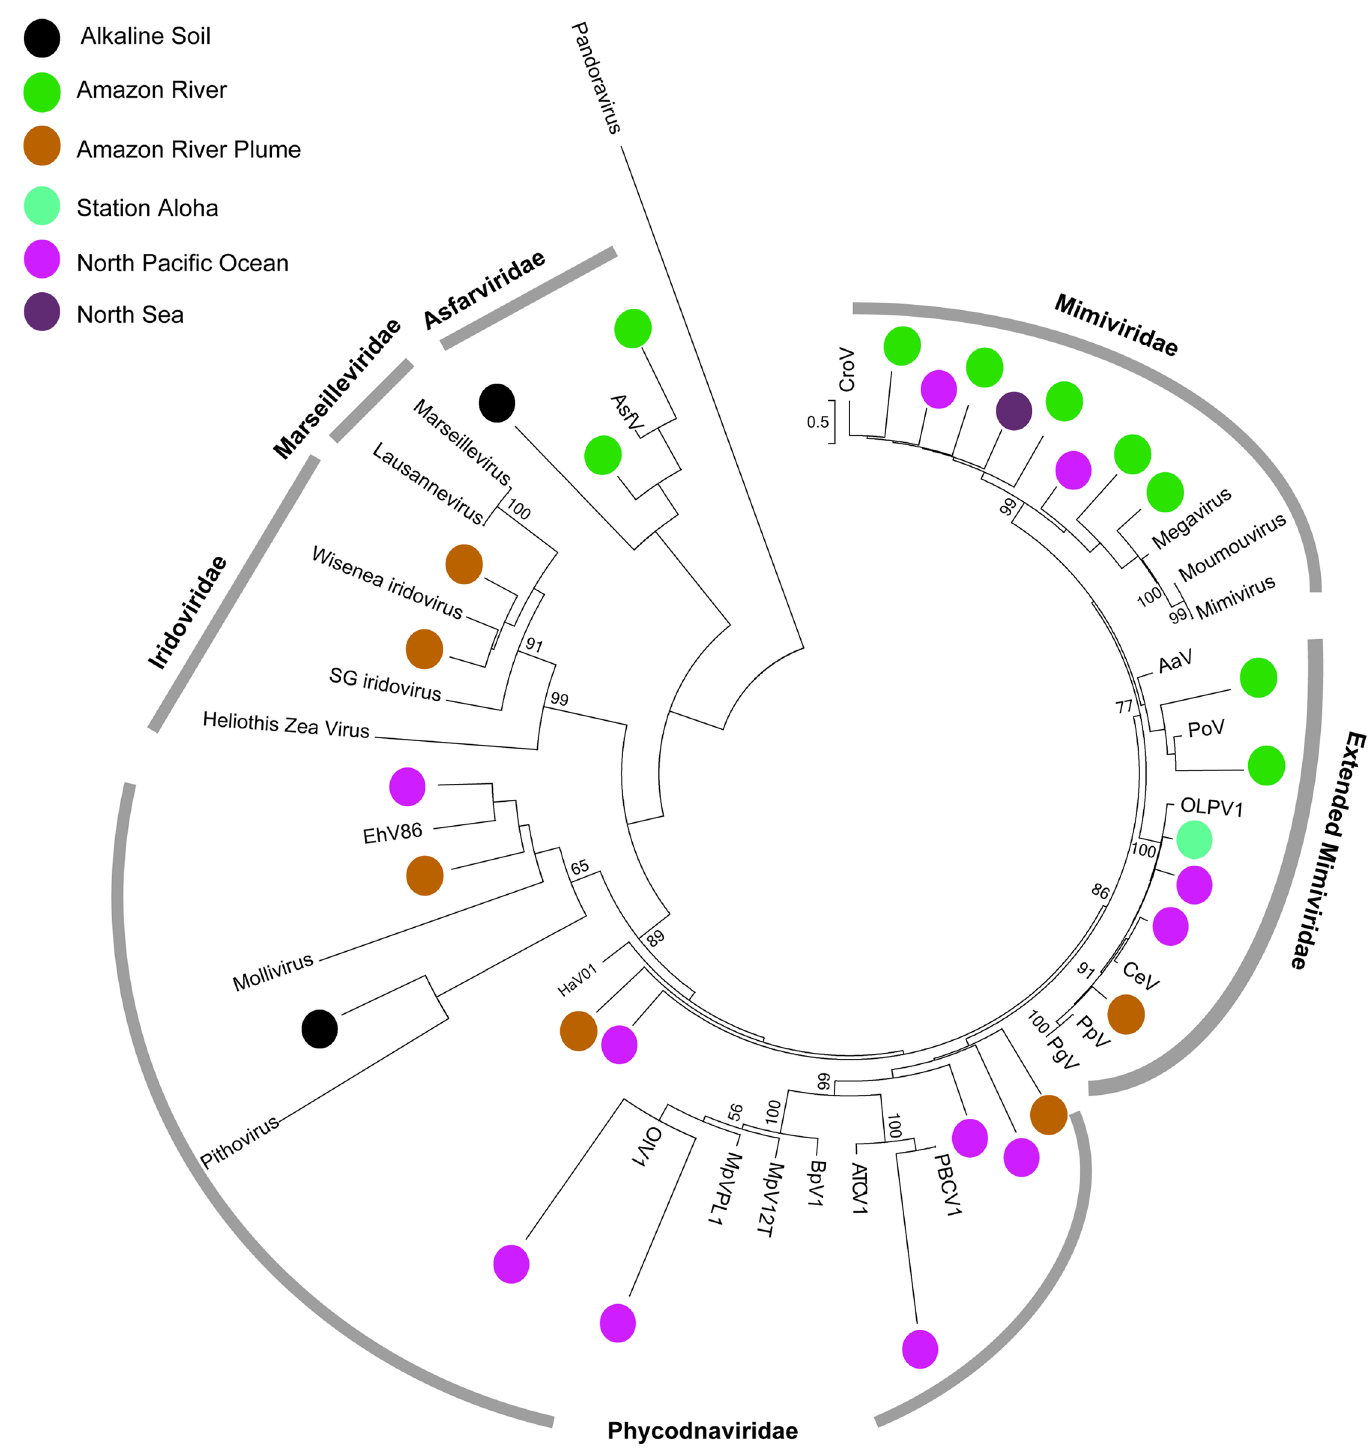
Fig 1. Phylogenetic reconstruction of NCLDV major capsid protein sequences from environmental metatranscriptomes generated from an alkaline soil sample (NCBI ID: SRP043976), the Amazon River and River Delta (SRP037995, SRP039544 [21]), the North Pacific Ocean (SRP052554 [22]), Station ALOHA in the tropical Pacific Ocean (CAM_SMPL_000824 at iMicrobe.us [23]), and the North Sea (ERP004582 [24]). Public metatranscriptomes were assembled and searched for NCLDV-like major capsid protein coding transcripts. MCP contigs > 300 bp with best hits to NCLDVs were aligned with an MCP reference database and placed on a maximum likelihood tree with a Shimodaira-Hasegawa-like approximate likelihood ratio test branch validation using pplacer (http://matsen.fhcrc.org/pplacer/). The broad spectrum of samples demonstrates active giant virus infections can be observed in many different